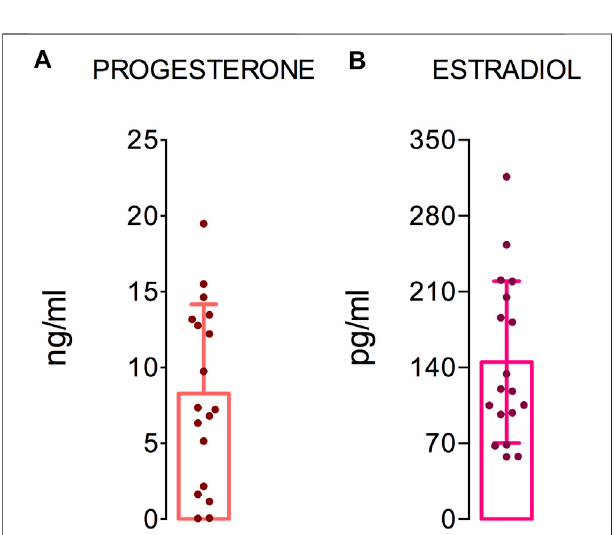
FIGURE 1 | Ovarian hormones levels. The graphs show the hormone levels in 18 women. The dashed (red) and dotted (black) lines show the reference values of progesterone and estradiol for the luteal and follicular phase of the menstrual cycle, respectively. The median, minimum, maximum, and fi rst and third quartile values are